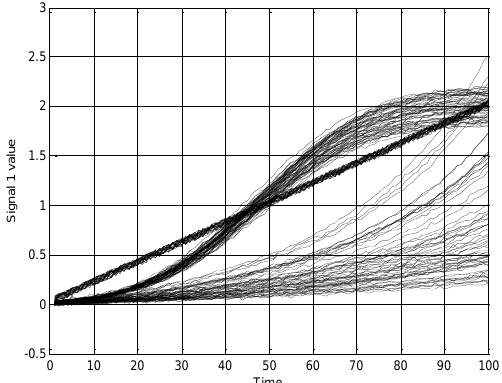
Fig. 1. Projection on the signal 1 axis of the 150 simulated transients.